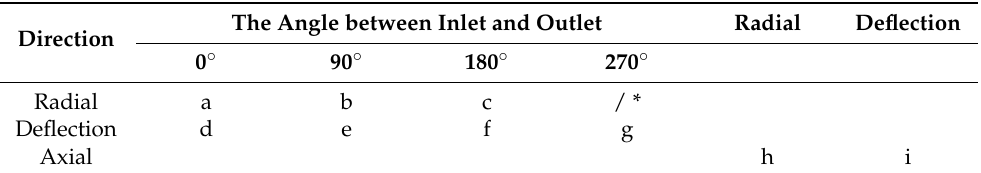
Table 1. Nomenclature of different cases.